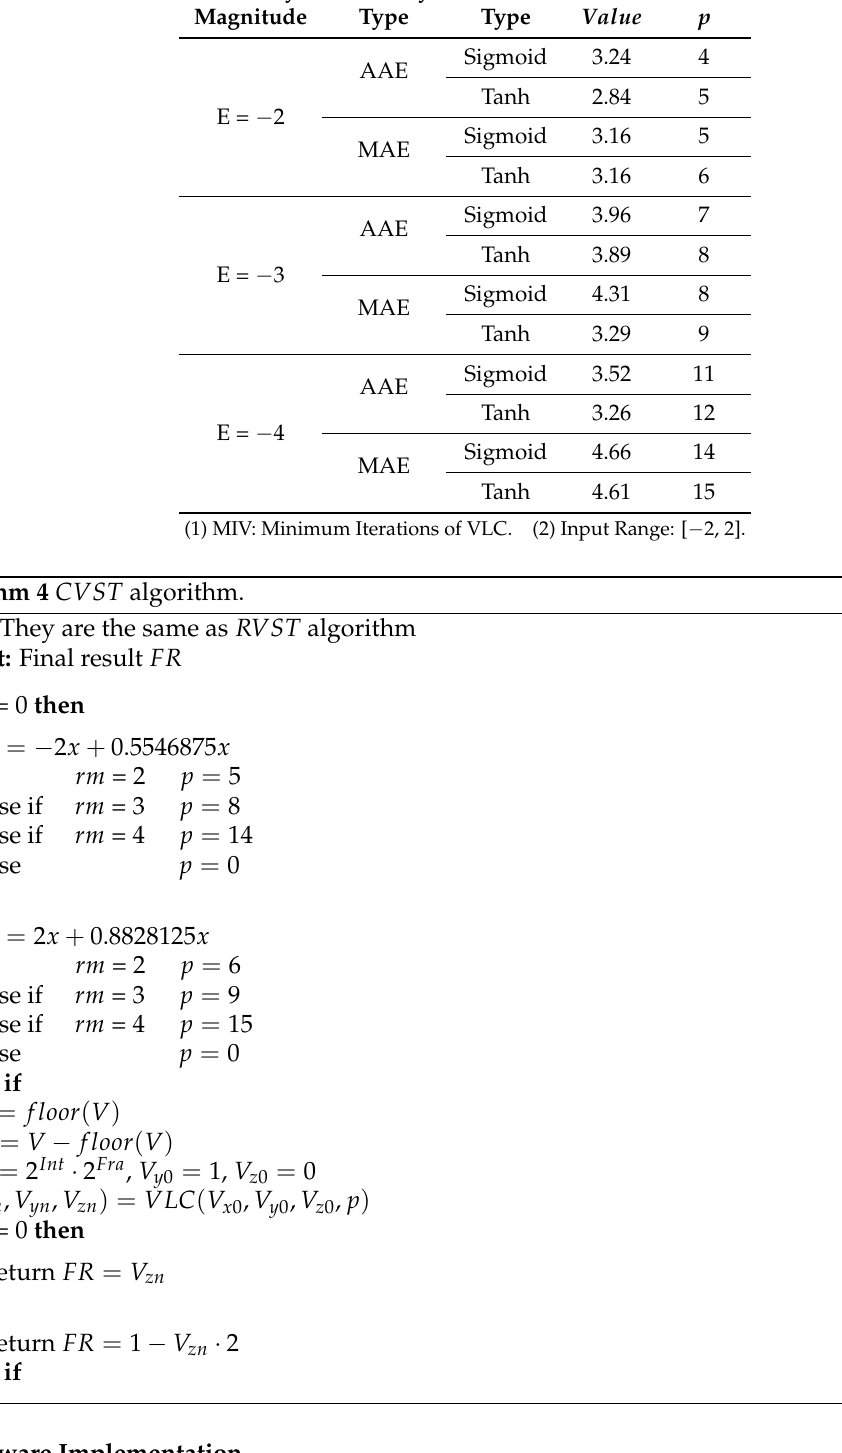
Table 6. Sigmoid: Relationship between the Magnitudes of Accuracy and the Iterations. Accuracy